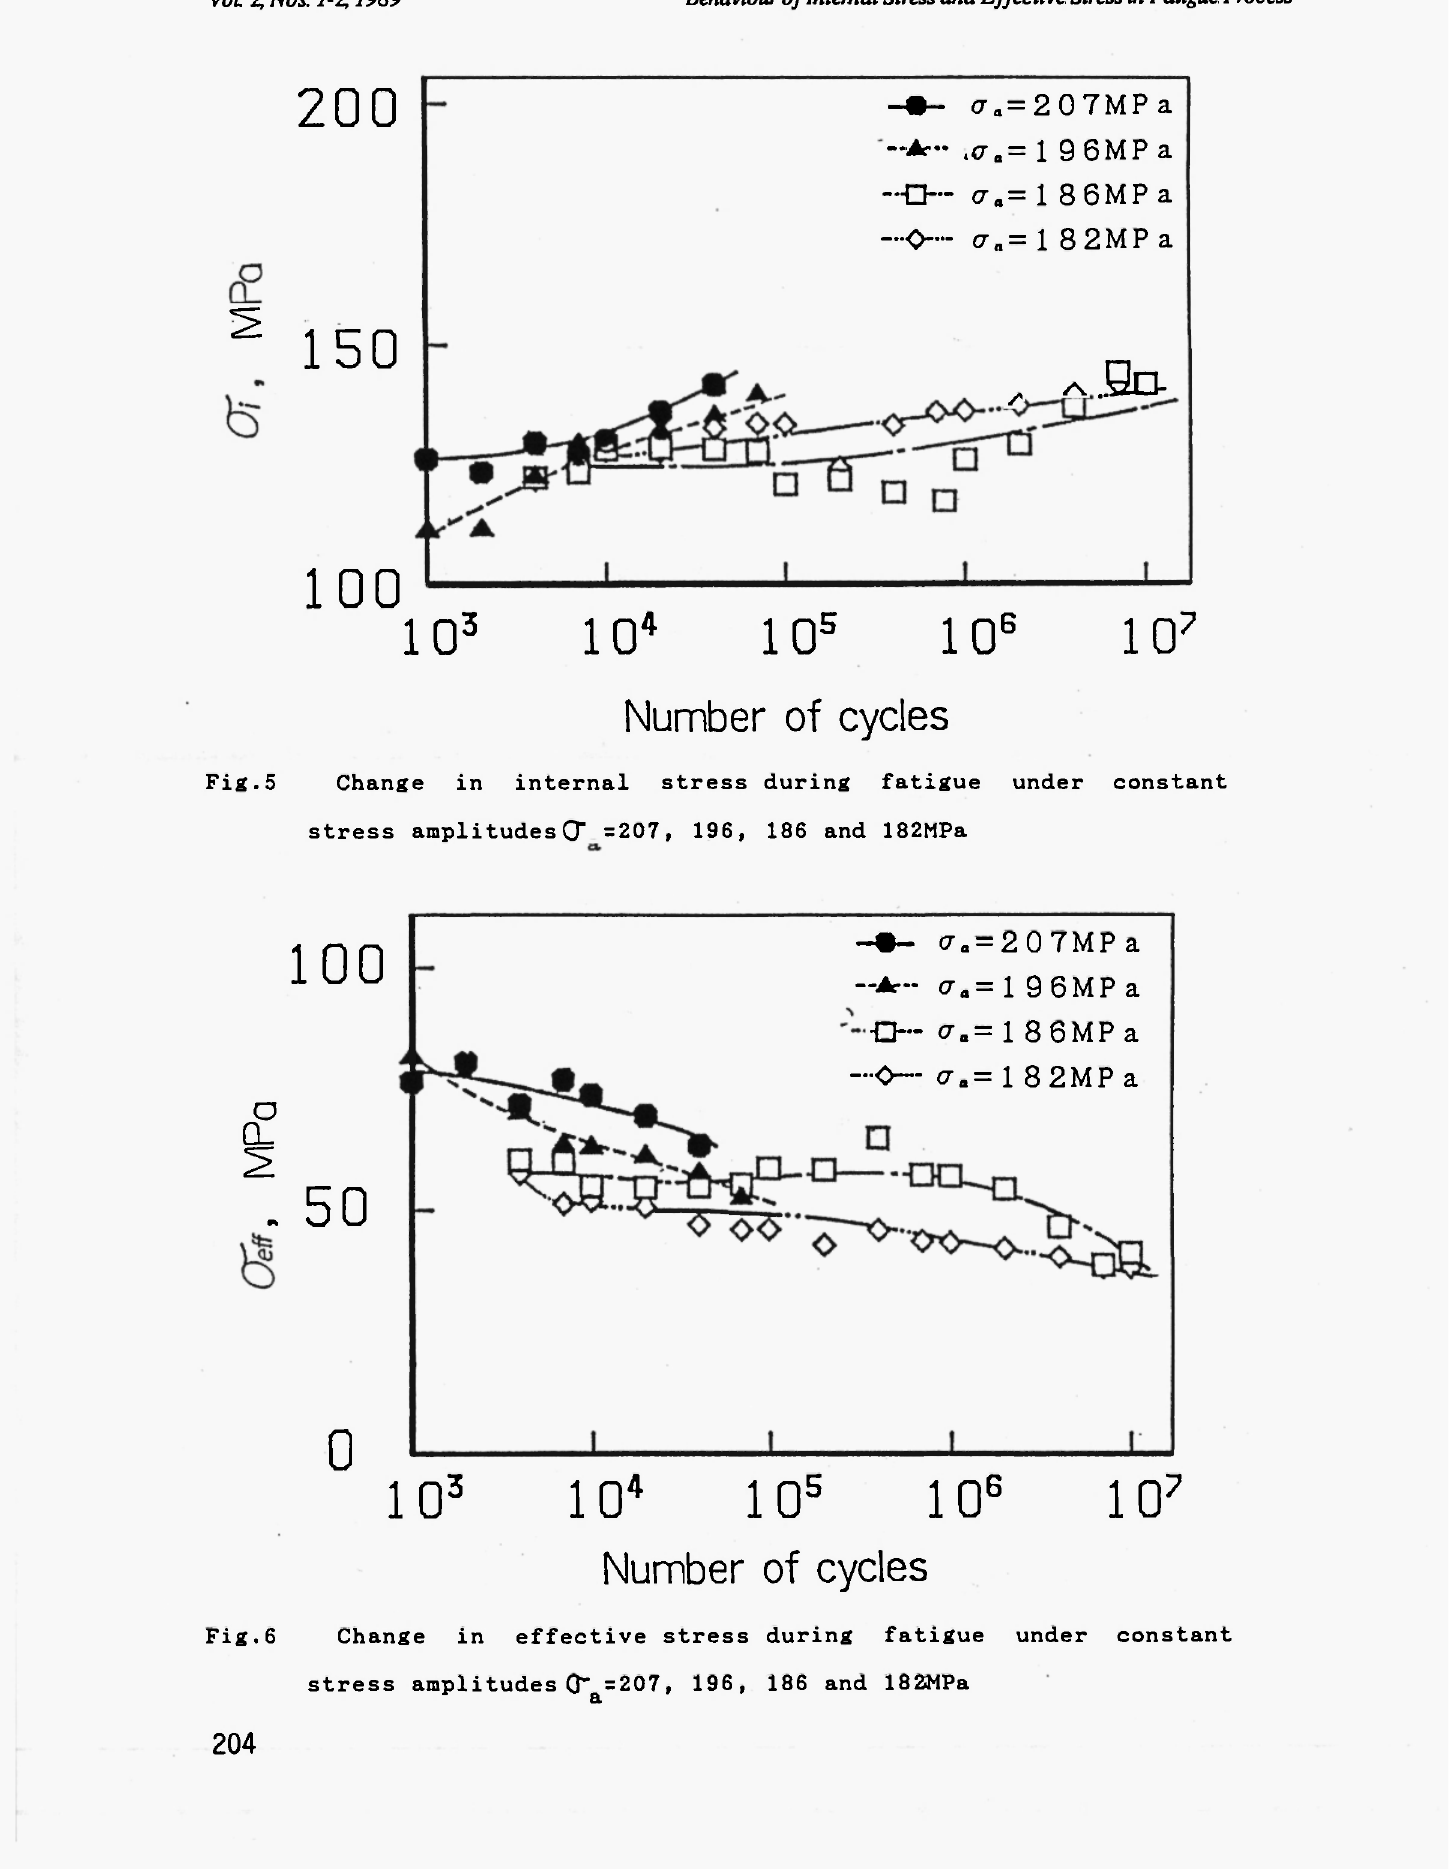
Change in effective stress during fatigue under constant stress amplitudes O" a =207, 196, 186 and 182WPa